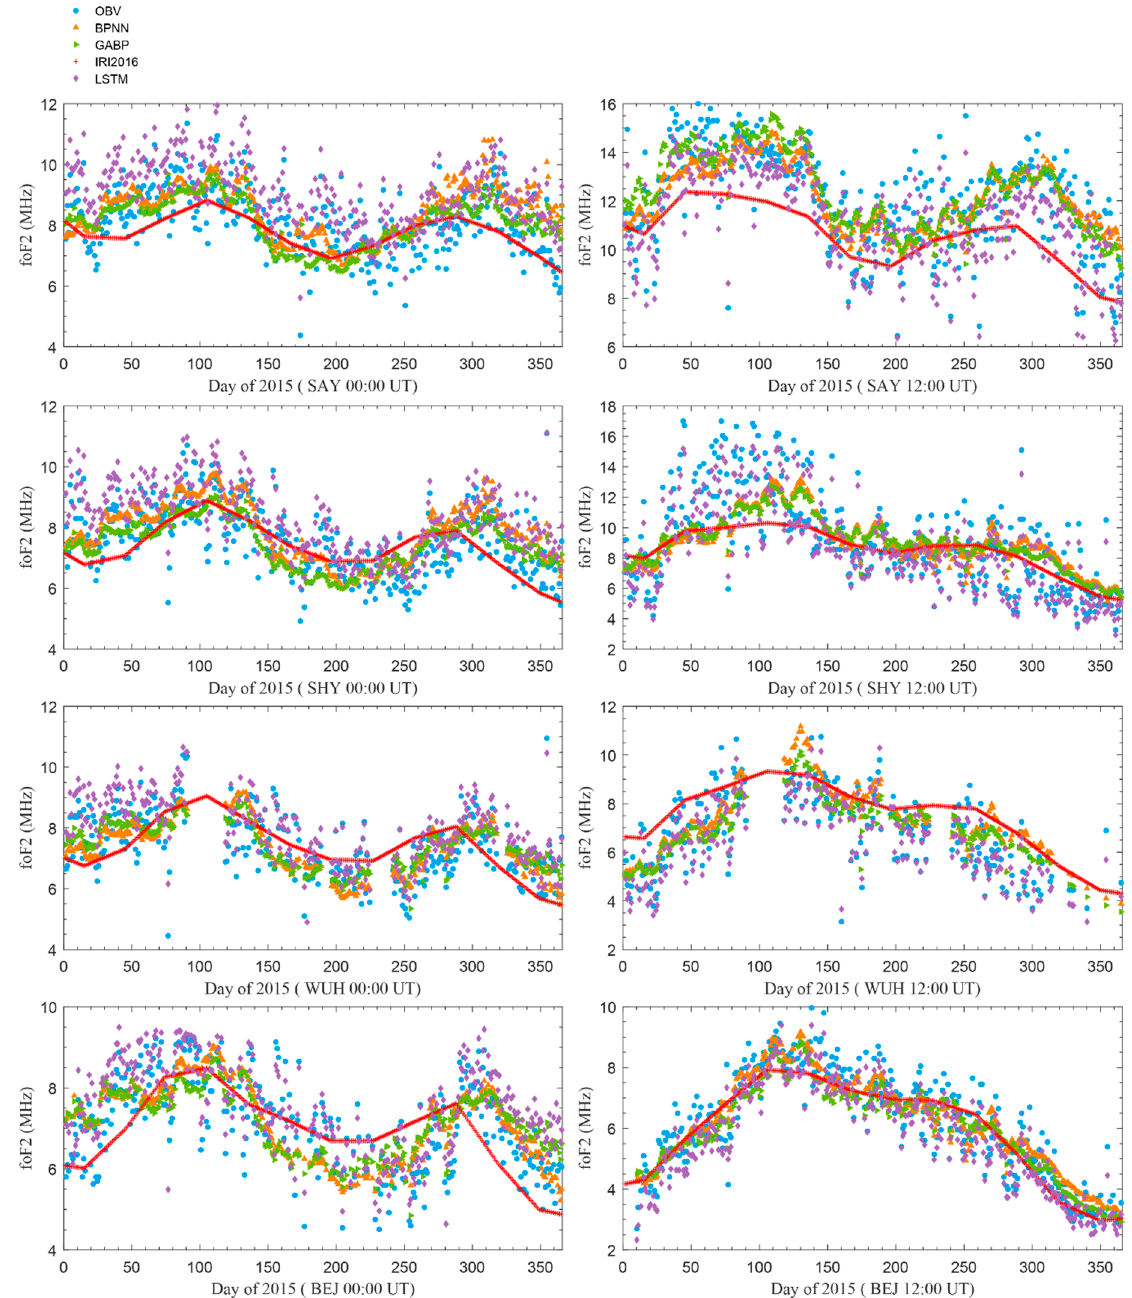
Figure 11. Same format as Figure 10, but for the year 2015.